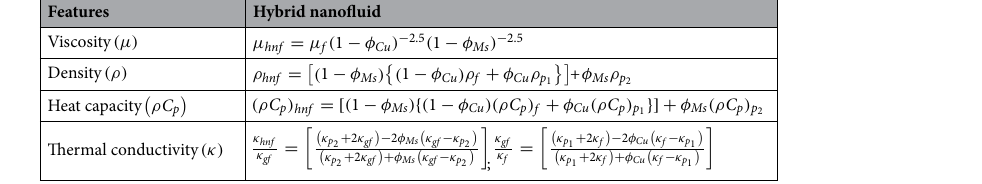
Table 2. Thermo-physical properties of hybrid nanofluids.